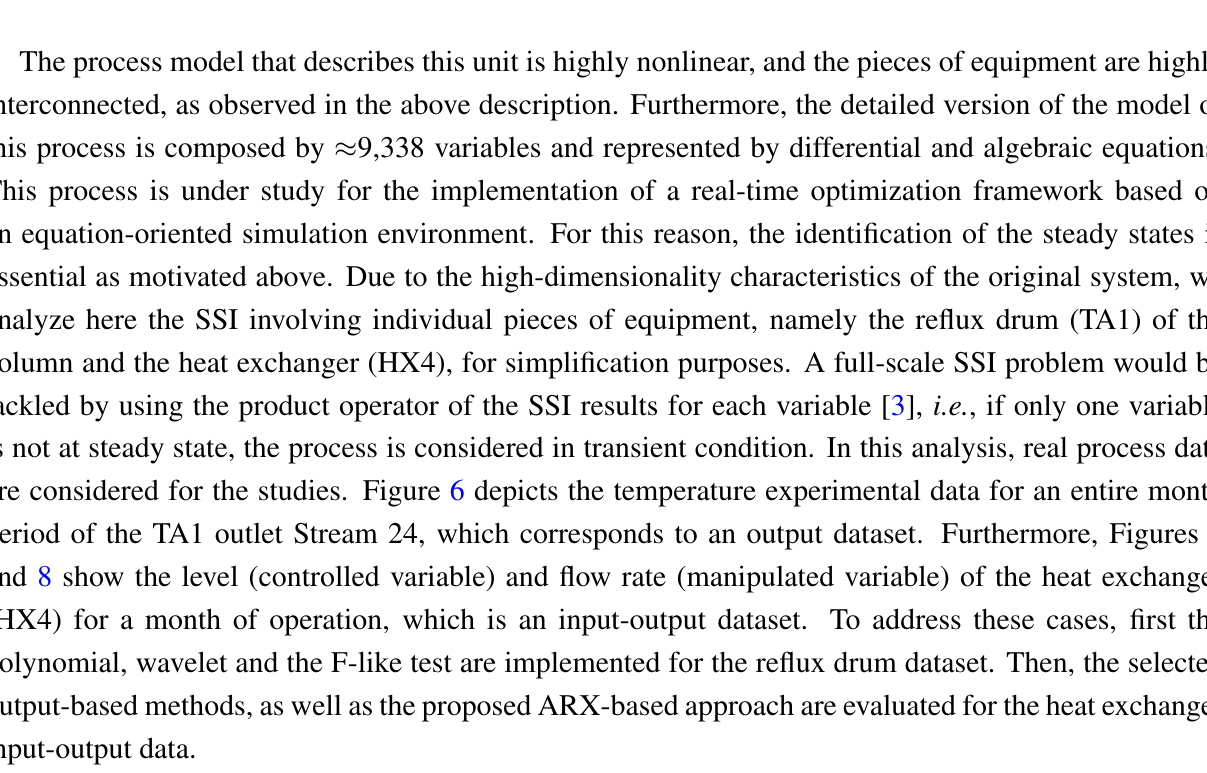
Figure 5. Depropanizer process